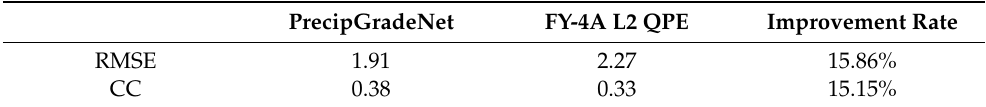
Table 11. Comparison of the precipitation intensity accuracy of the PrecipGradeNet and FY-4A L2